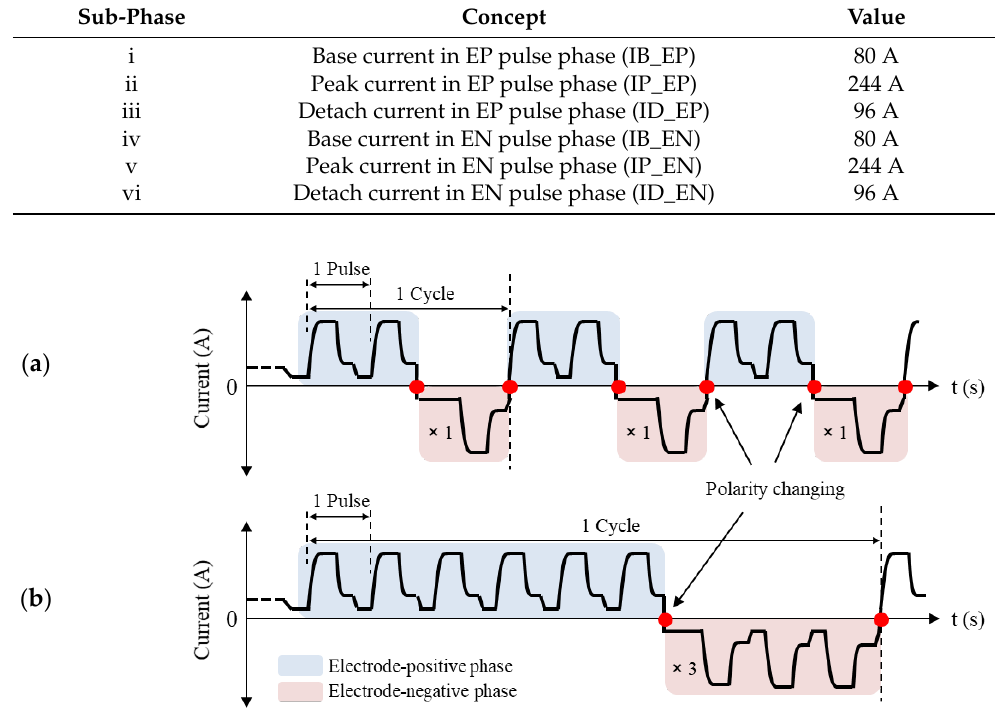
Figure 3. Current waveform schemes associated with an EN pulsing ratio of 0.33, with variable repetition in ( a ) one and ( b ) three times.